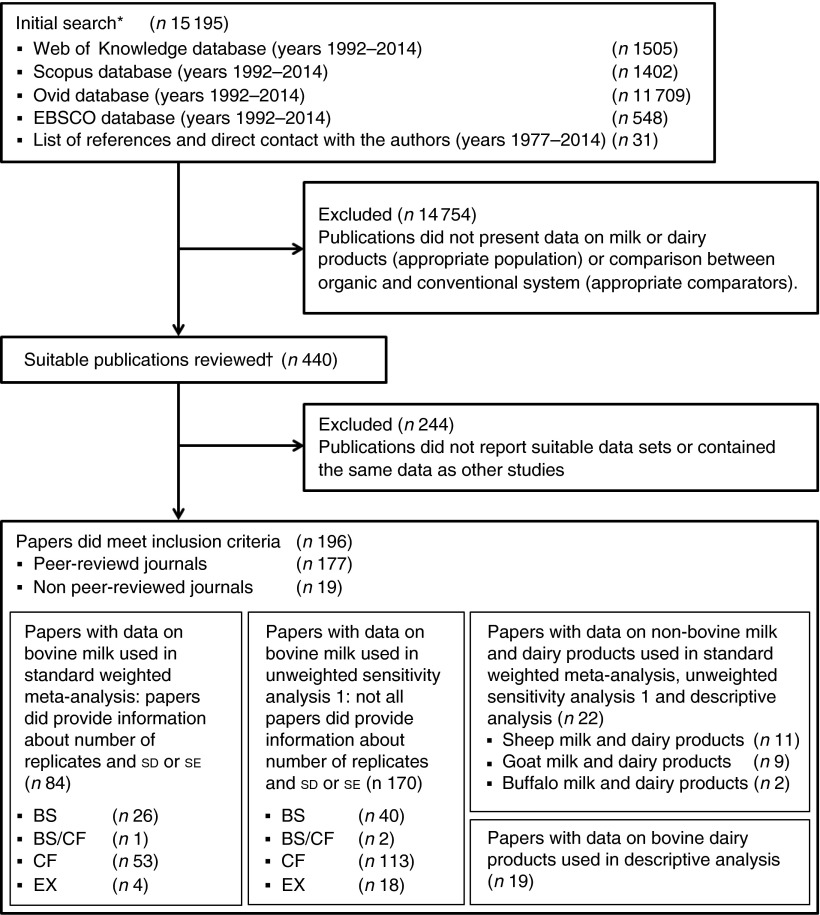
Summary of the search and selection protocols used to identify papers included in
the systematic review and the meta-analyses. * Review carried out by one reviewer; †
data extraction carried out by two reviewers. CF, comparison of matched farms; BS,
basket studies; EX, controlled experiments.